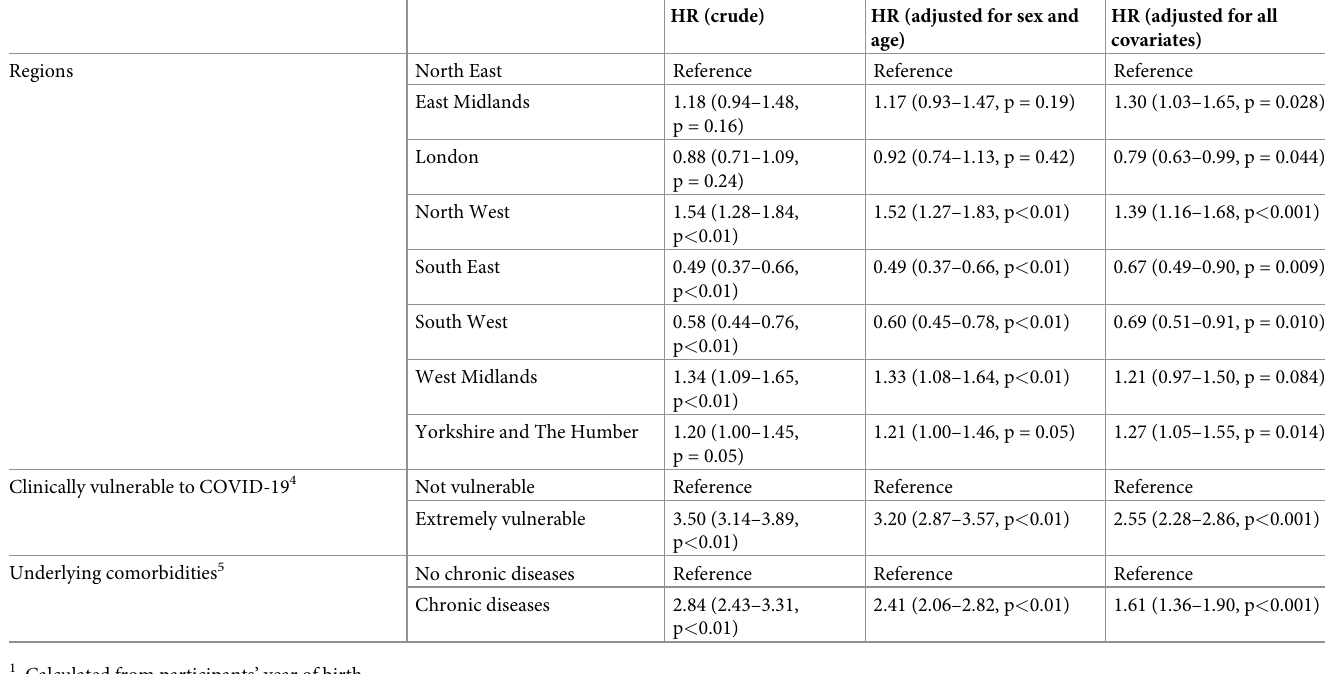
ation was not seen. We found either during or after British summertime months, after adjust- ing for covariates and compared with people with sufficient vitamin D status, no evidence existed that vitamin D insufficiency or deficiency was associated with a higher hazard of hospi-